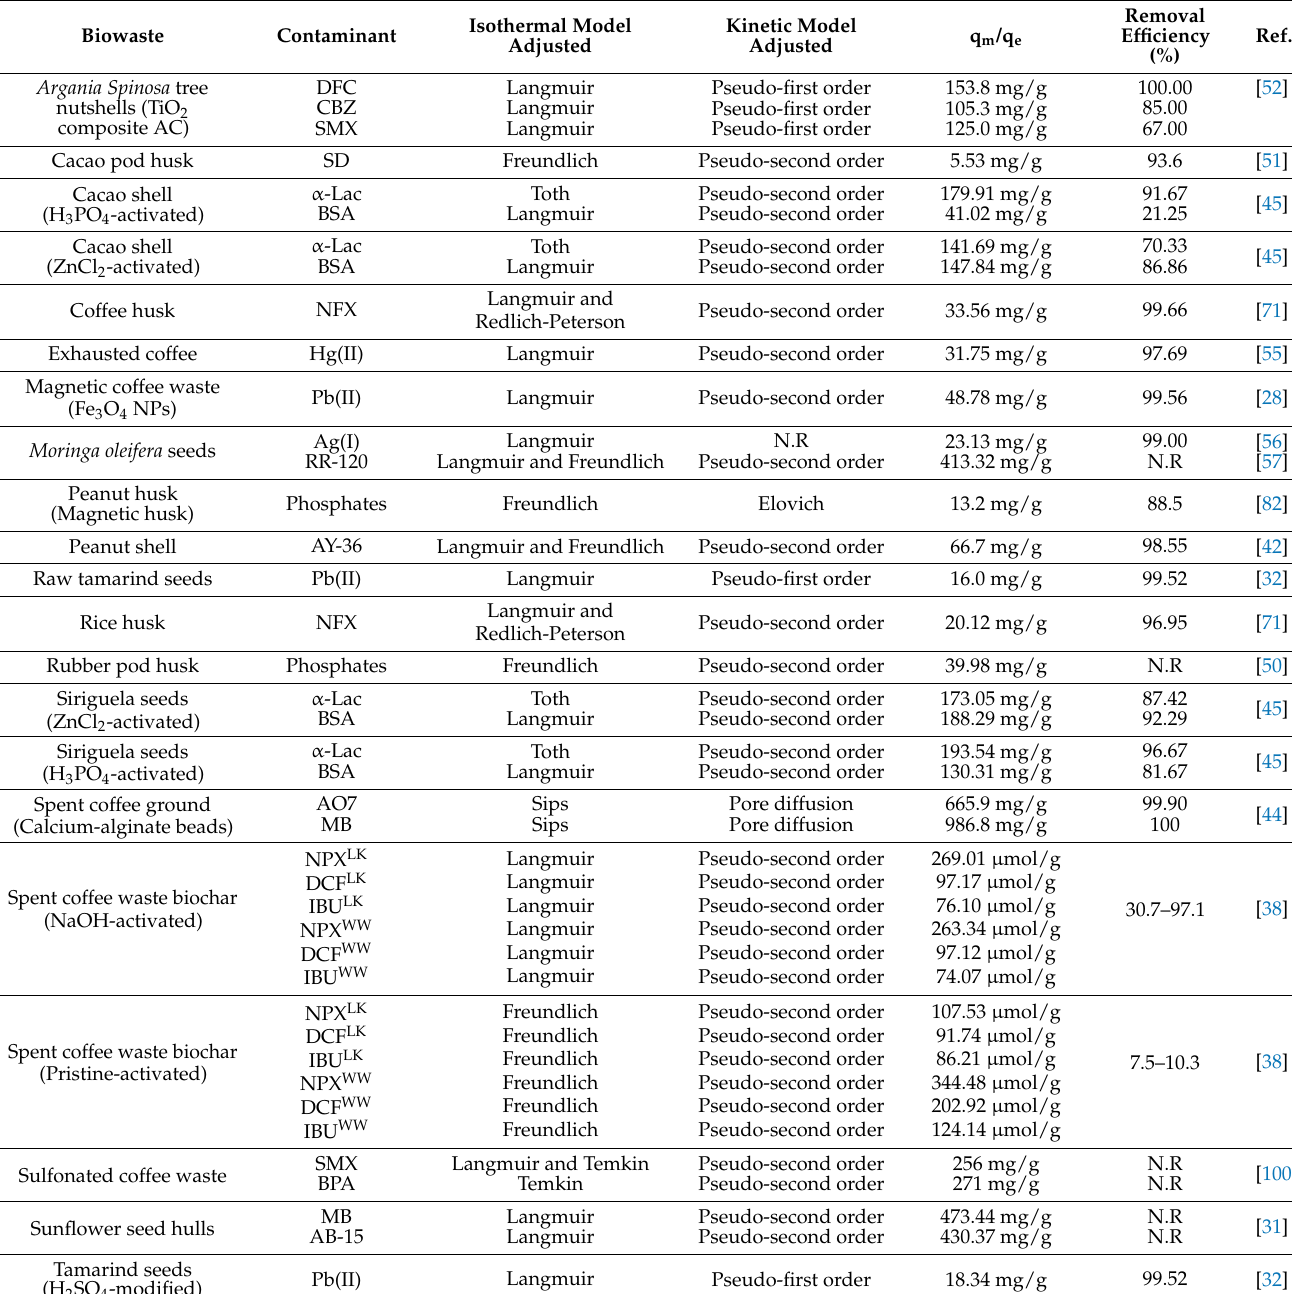
Table 3. Adsorption parameters and removal efficiencies of different biosorbents derived from grains and seeds for the removal of pollutants in aqueous